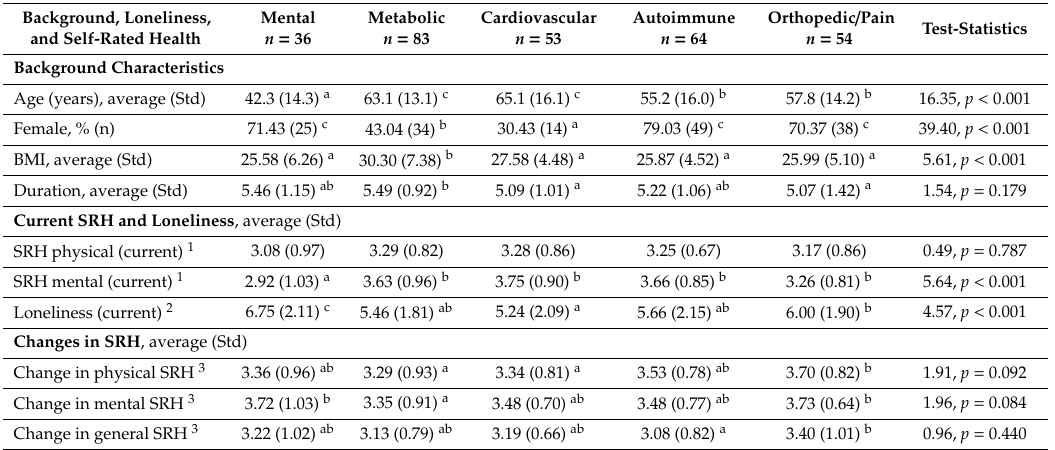
Table 4. Background, Loneliness, and Self-Rated Health (SRH) by Medical Condition